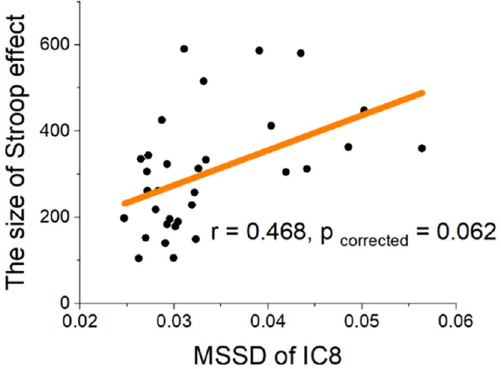
Figure 3. The correlation between the size of Stroop effect and brain variability of the attention network (i.e., IC8) was close to significance. The higher the brain variability of IC8 estimated by MSSD, the larger the size of Stroop